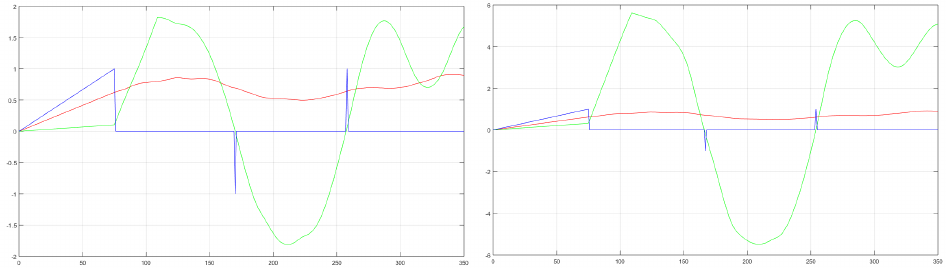
Figure 8. Trend analysis of daily opening BTS–USD from 17-12-2020 to 30-11-2021 after normalisation. The BVR ( left ) and the LVR ( right ) are computed using the function Backtester(40,35,350) given in [14]. In both cases, the normalised BTS–USD data are plotted after application of a moving average filter (red lines). The green lines shows the post-filtered BVR and the LVR signals. The zero-crossing positions (blue lines) indicate the points in time where a change in the trend of the filtered signals takes